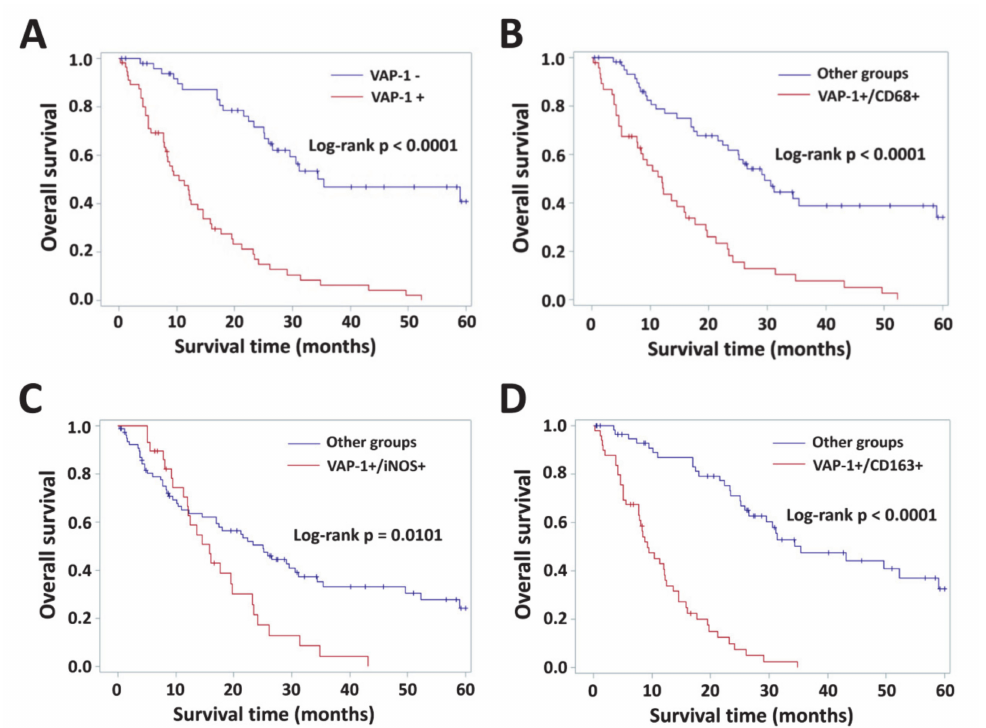
Figure 3. Kaplan–Meier plots for glioma patients with di ff erent levels of VAP-1 alone or VAP1 / TAM coexpression. ( A ) VAP-1 expression had a significant e ff ect on survival in 108 patients with glioma. Survival in patients that had tumors with positive coexpression of VAP-1 / TAM markers ( B , CD68; C , iNOS; D , CD163) in comparison with other phenotypes was observed. p < 0.05 was